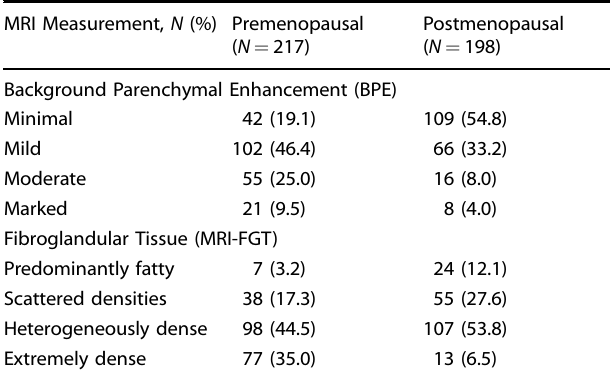
Table 2. Distribution of background parenchymal enhancement